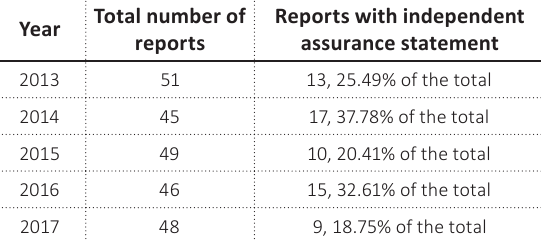
Table 4. Total number of integrated reports in